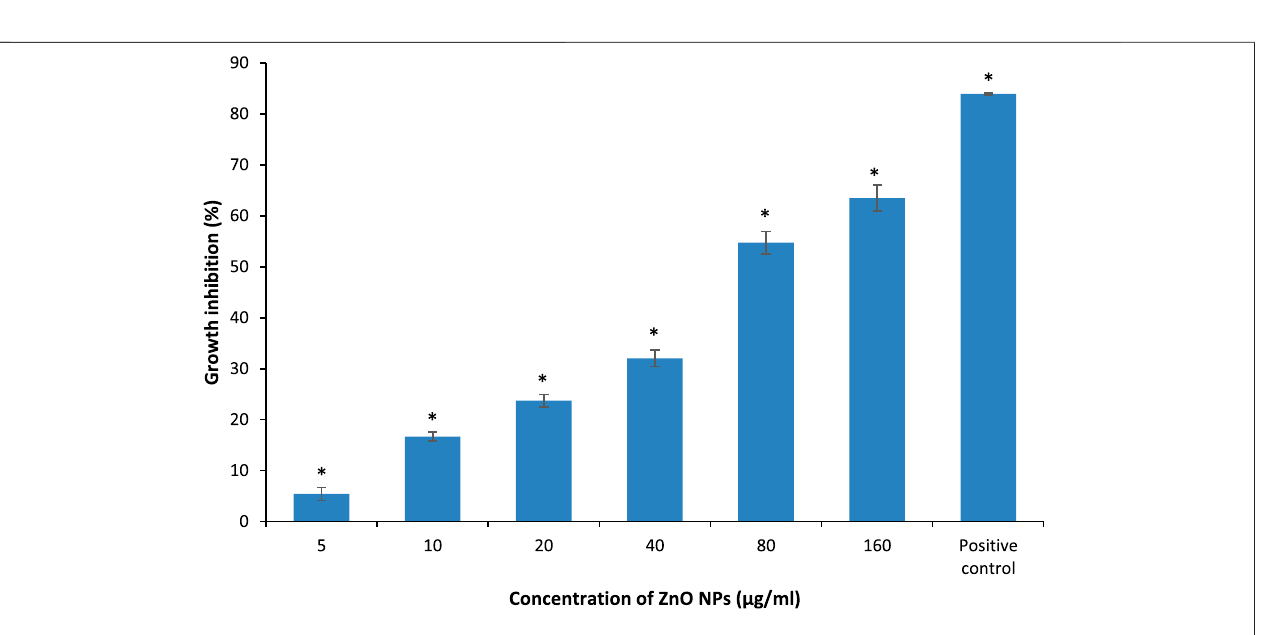
Frontiers in Pharmacology |